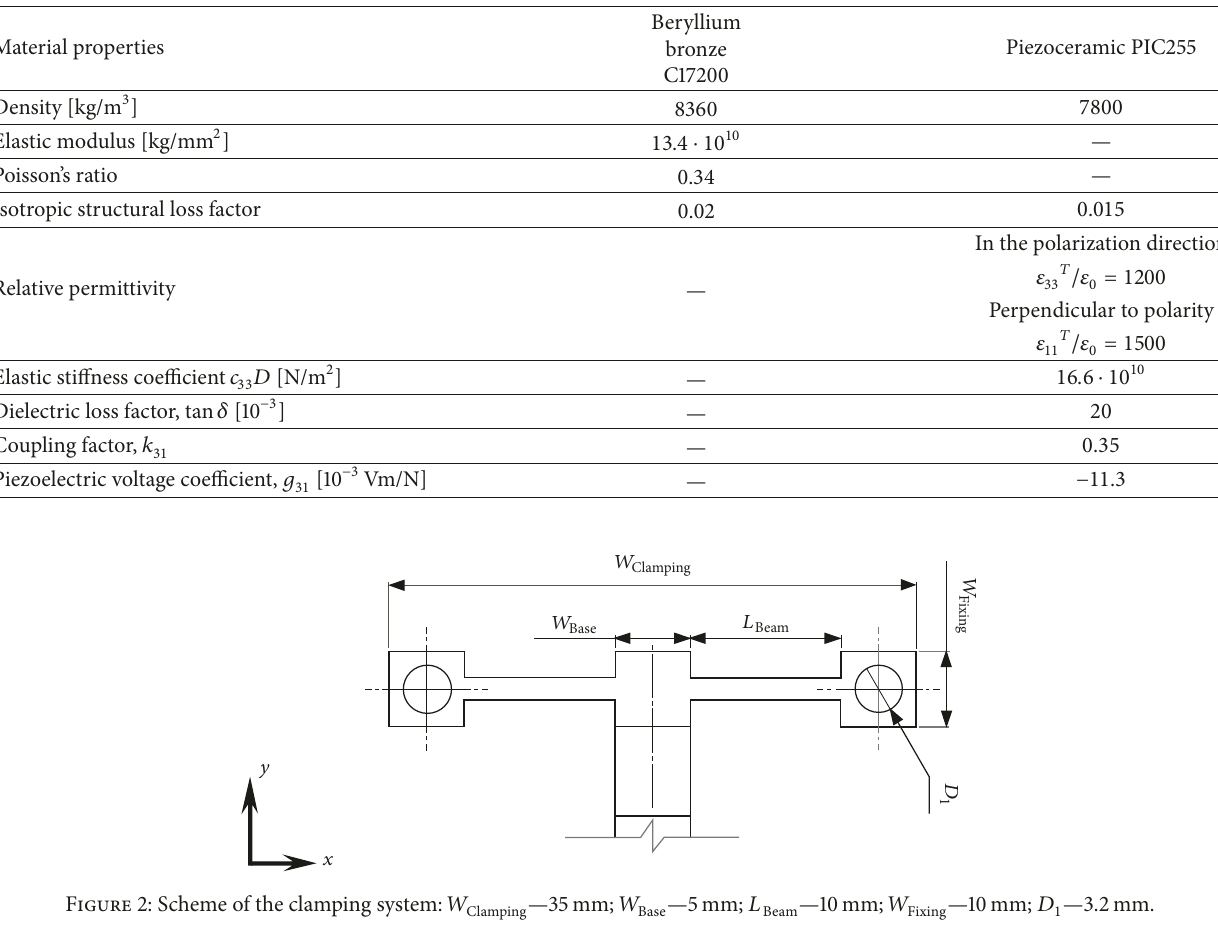
Table 1: Material properties.